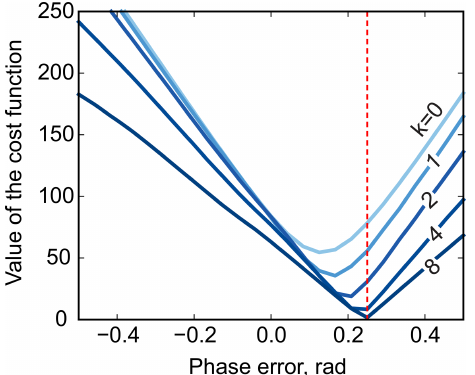
Figure 5. The phase-adjustment cost function, (cid:107) r b (cid:107) 2 , plotted against the phasing error. Different curves correspond to median filters of different width, w m = k · FWHM. The red vertical line in- dicates the true phasing offset in the simulations.